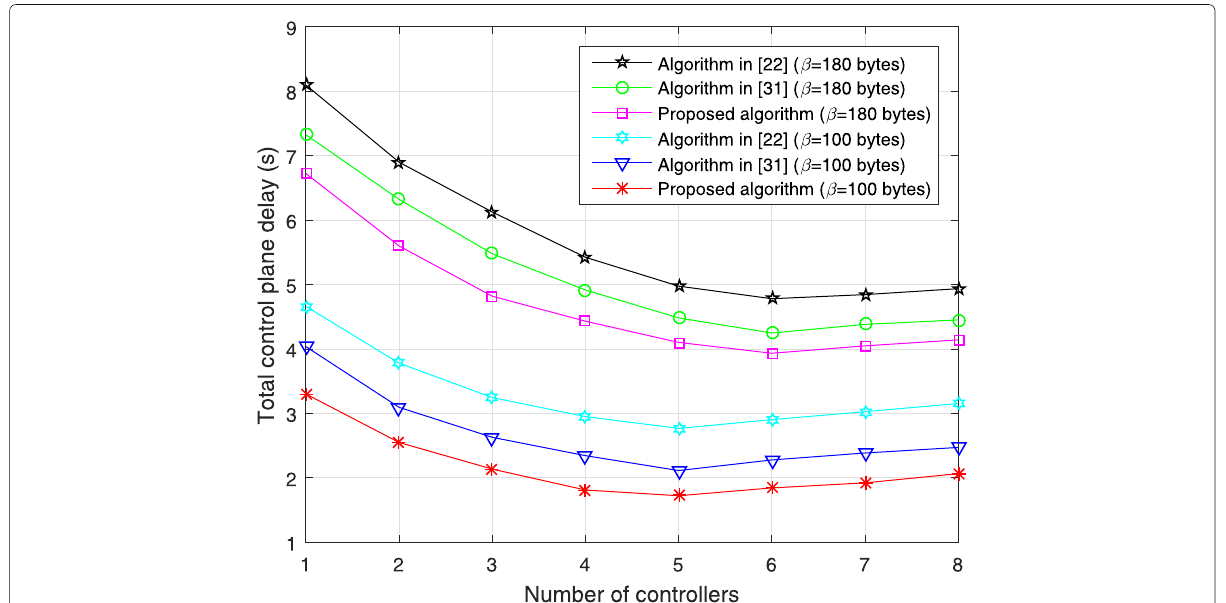
Fig. 5 Control plane delay versus the number of controllers (different β ). The control plane delay versus the number of controllers for different β